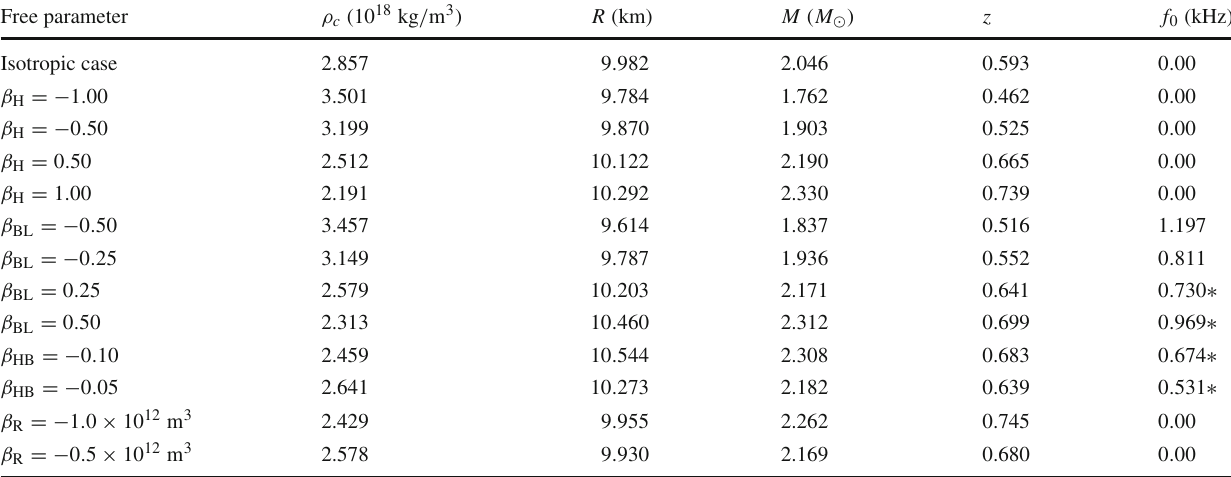
maximum. The fundamental mode frequency with an asterisk means that it is imaginary, and z ( R ) = e λ( R ) − 1 is the gravitational redshift of light emitted at the surface of the equilibrium star